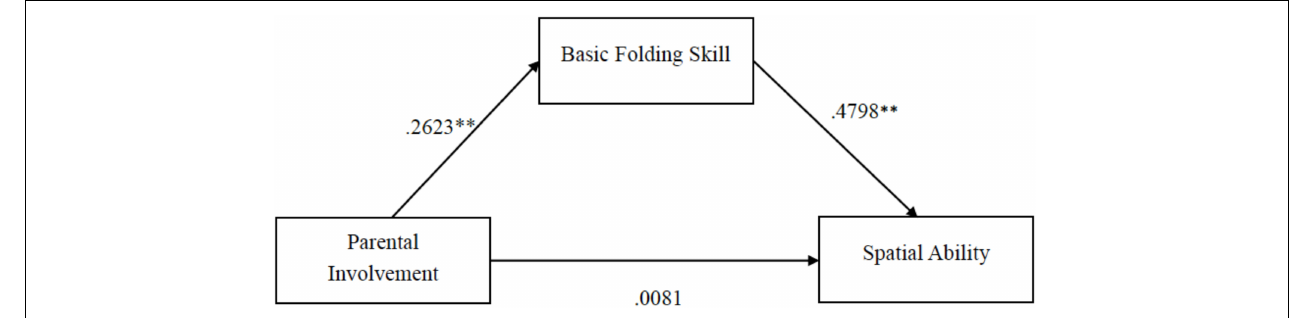
FIGURE 3 | The confirmed mediation